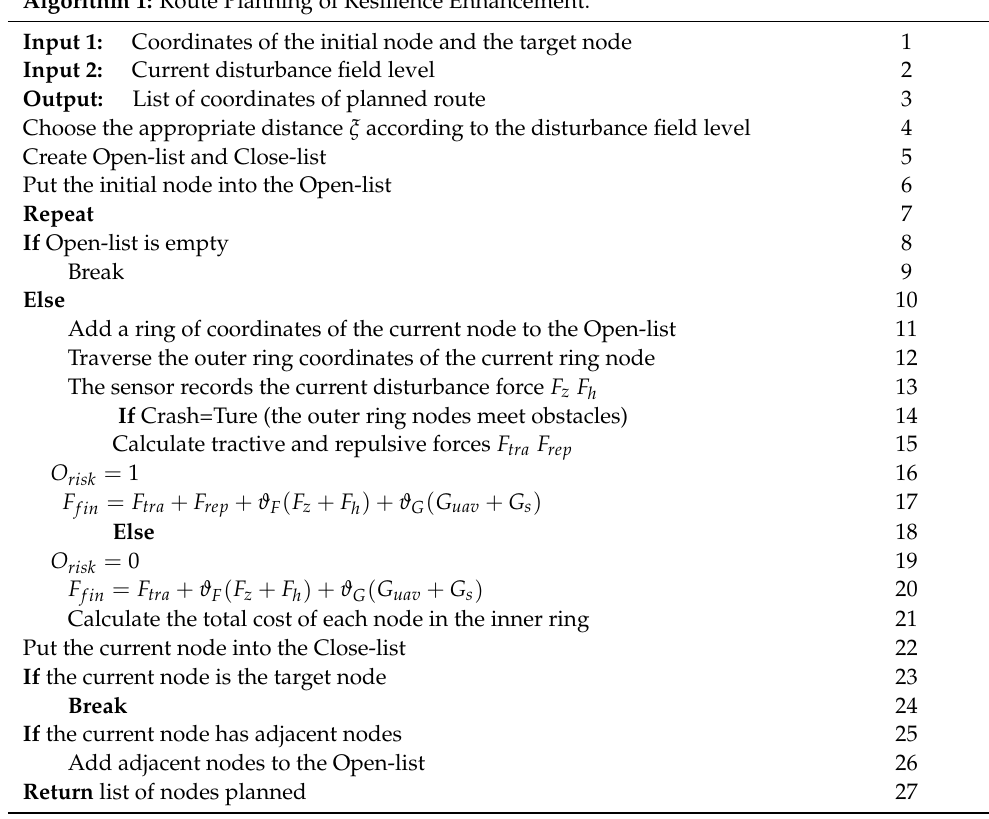
Algorithm 1: Route Planning of Resilience Enhancement.